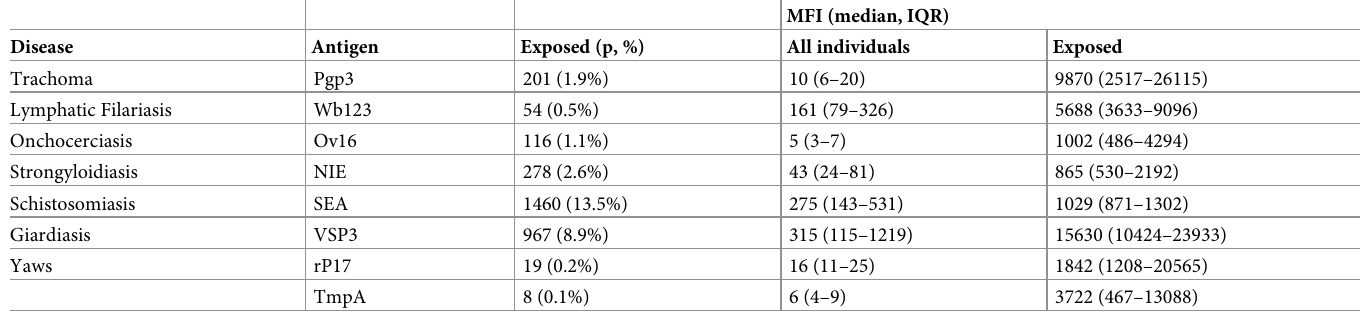
Table 1. Estimates of seroprevalence by antigen and disease, including distributions of responses for all individuals and individuals classified as exposed.